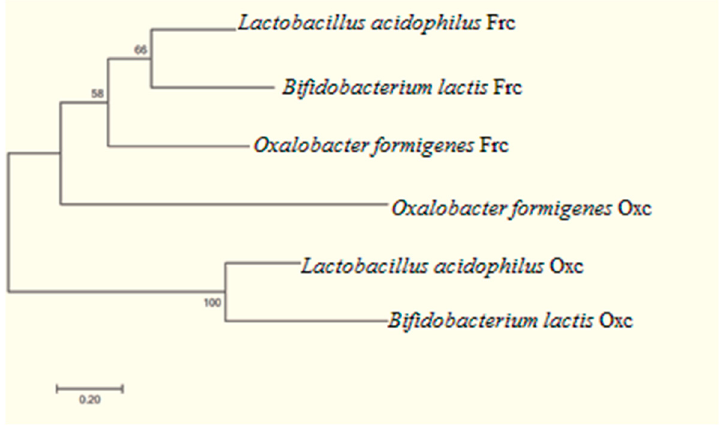
Figure 4. Molecular phylogenetic analysis by maximum likelihood method.